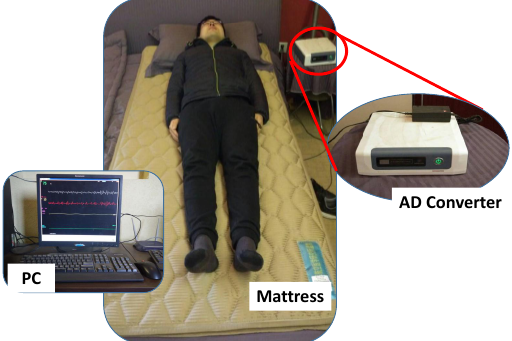
Figure 1. The micro-movement sensitive mattress based BCG signal acquisition system (RS-611).